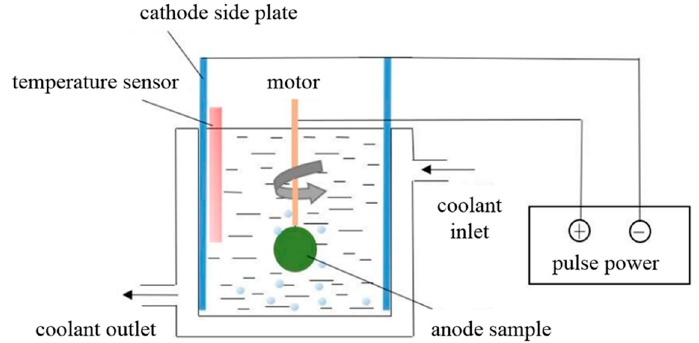
Figure 1. MAO experimental device. Table 1. The processing time in each electrolyte and the corresponding labeling method of each sample. Electrolyte